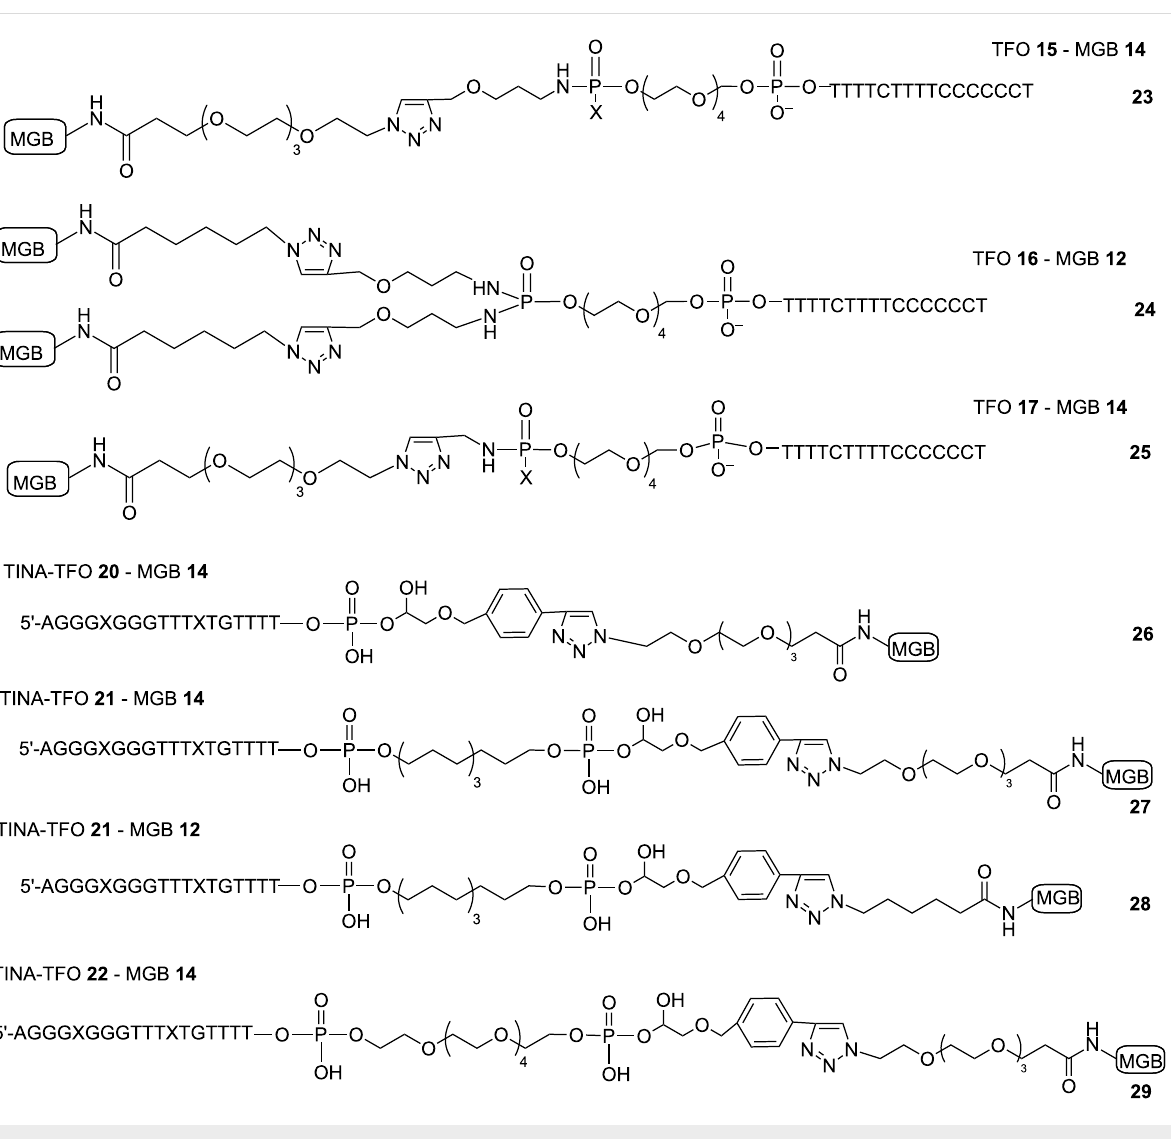
Figure 12: Structures of polyamide-TFO